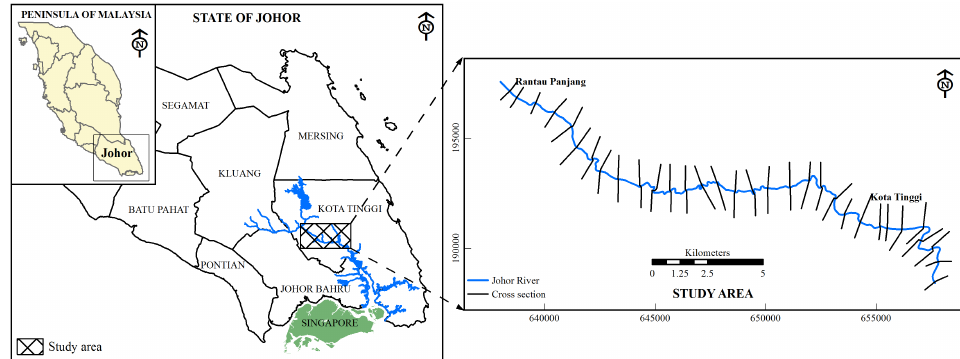
Figure 1. Layout map of study area: Johor River, Malaysia.